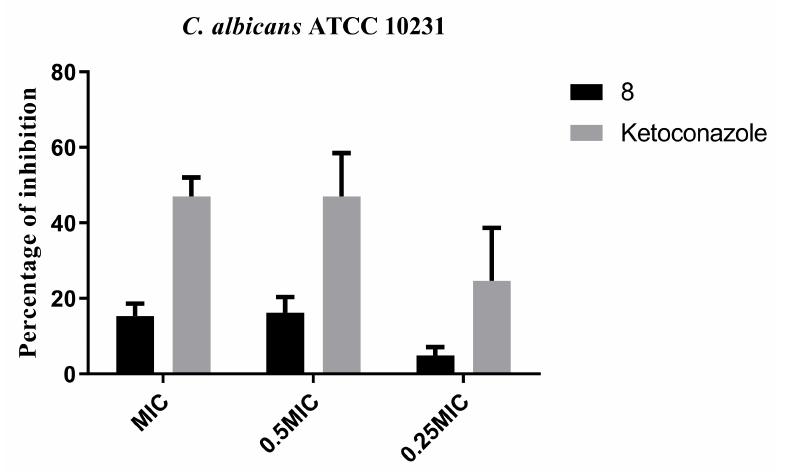
Figure 3. Percentages of inhibition of C. albicans ATCC 10231 biofilm formation by compound 8 and